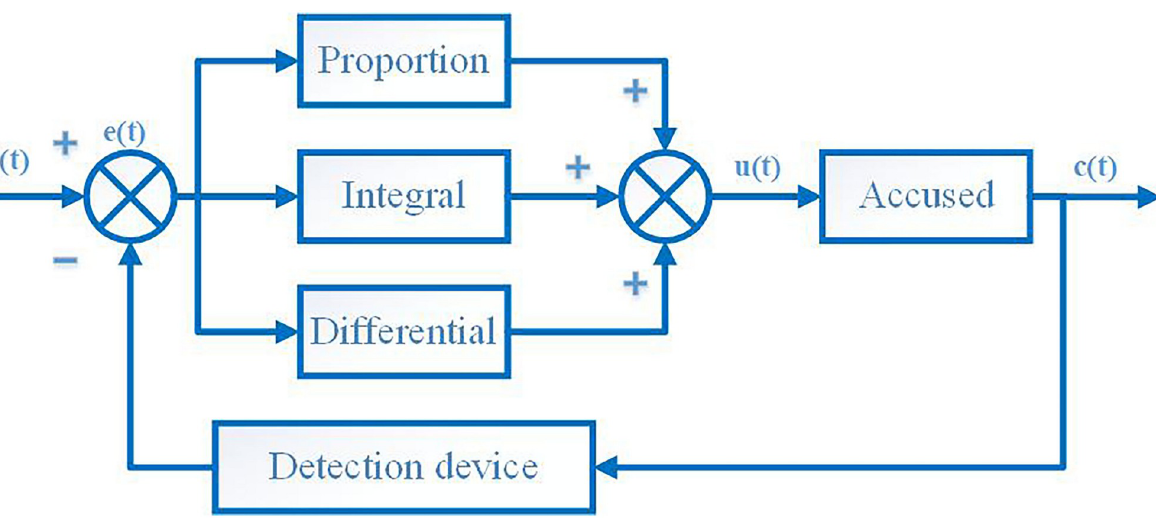
Fig 11. Structure diagram of PID control